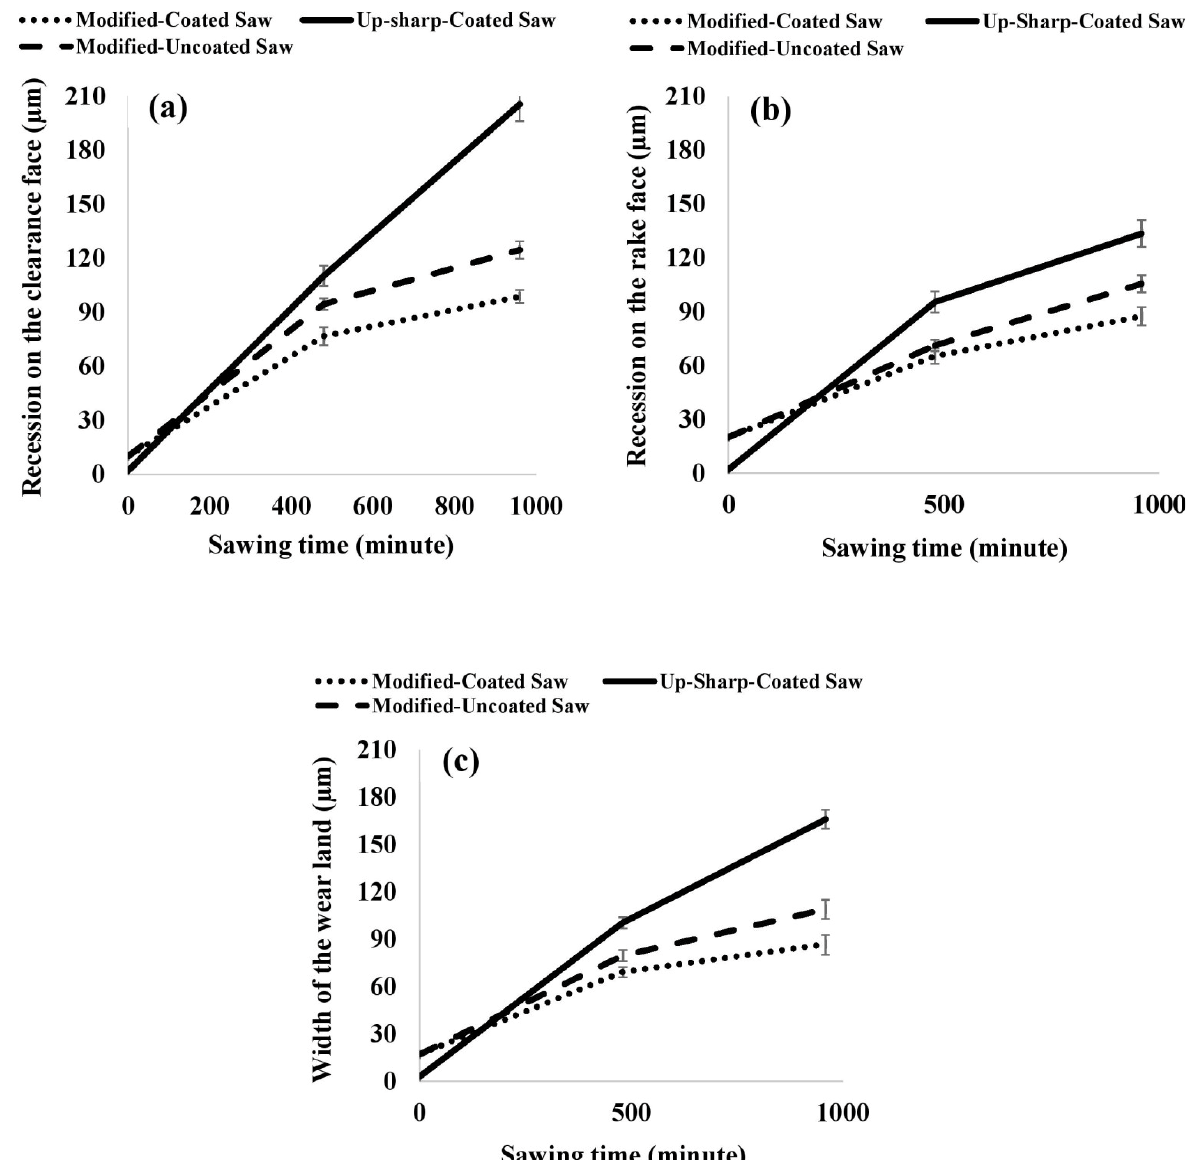
Figure 21. Wear of circular saws as a function of sawing time, ( a ) recession on the clearance face, ( b ) recession on the rake face, and ( c ) width of the wear land. Table 8. Rate of wear of saws 2, 4 and 6 as a function of sawing time at the sawmill. Second Phase of the (between 480 min and 960 min of